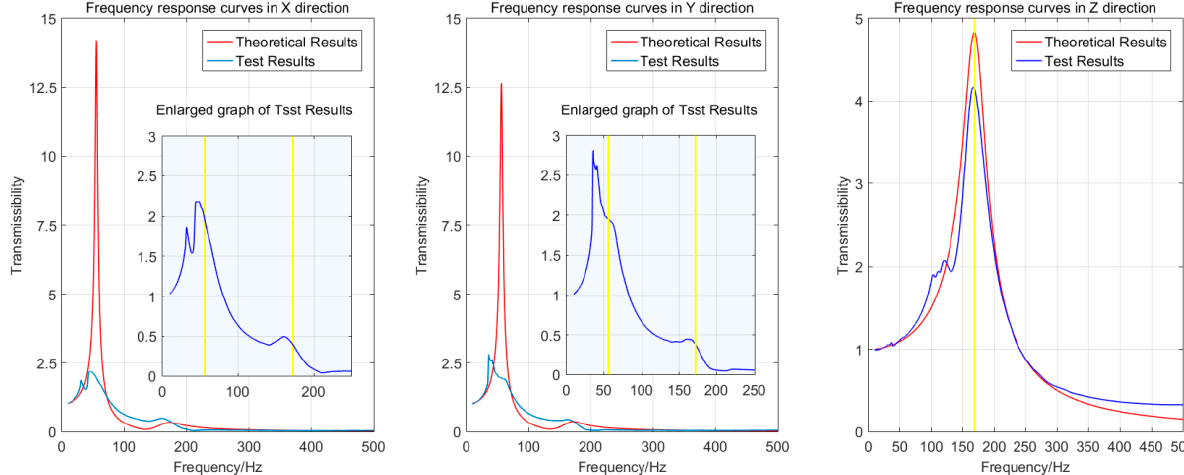
Figure 13. Frequency response curves obtained from theoretical calculation and tests.